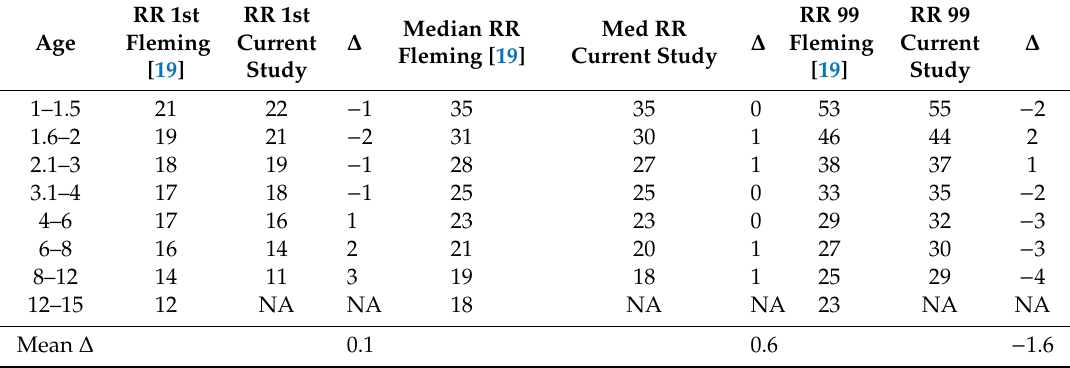
Table 5. Comparison of awake RR data from current study and study by Fleming et al. [19] (1st Centile, Median and 99th